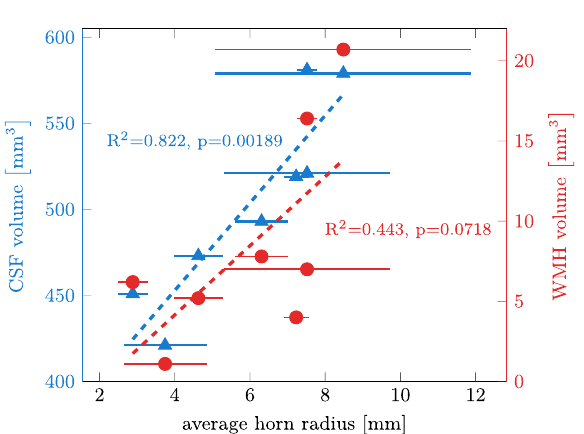
Figure 4. Horn radius versus CSF volume and WMH volume. We show the average of all four horn radii for each subject (marker with standard deviation as a horizontal line). We observe an overall increase of horn radius with increasing CSF and WMH